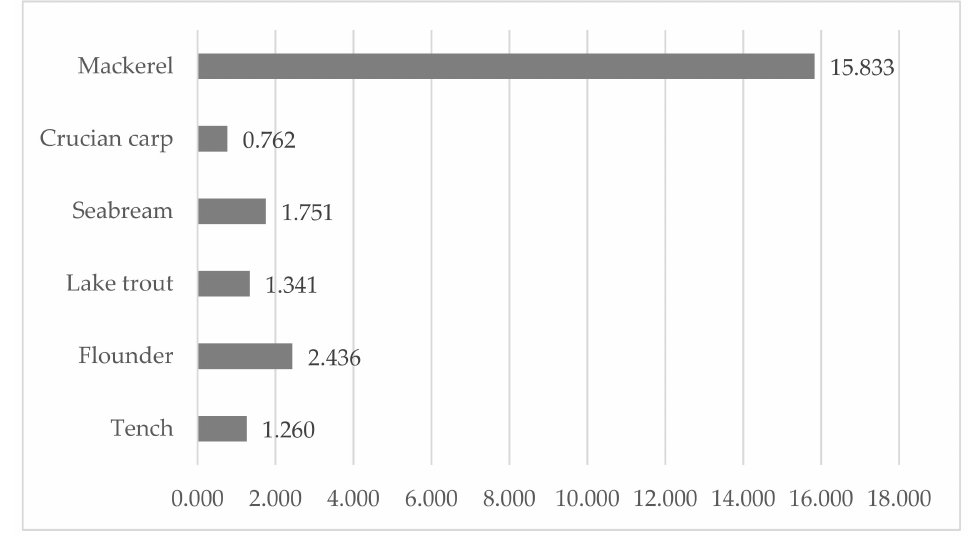
Figure 2. The content of sum of EPA and DHA (mg/g).